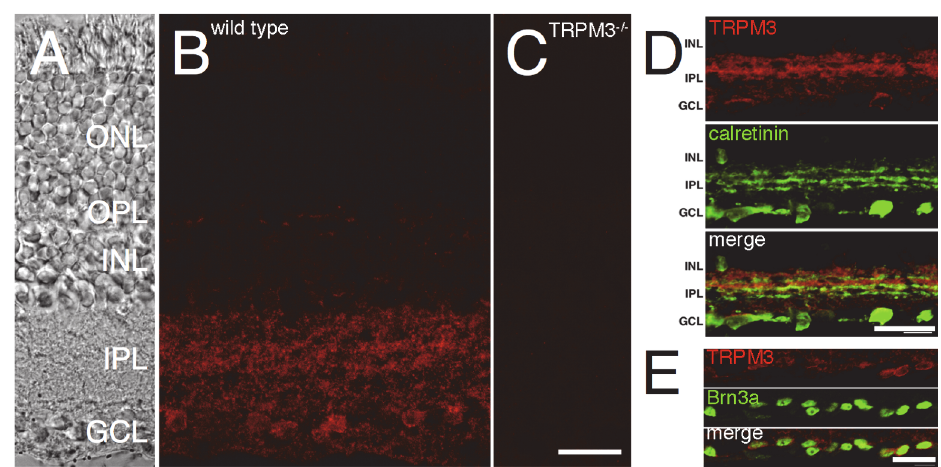
B ) TRPM3 immunoreactivity is observed in the IPL and GCL of a WT mouse retina. C ) No immunoreactivity is detected in a retinal section from a TRPM3 -/- mouse. D ) Transverse retinal sections of the inner retina double- labeled for TRPM3 (top, red) and calretinin (middle, green). Visible in the merged image (bottom), the outer, OFF half of the IPL (sublamina a) is more strongly labeled than the inner, ON, sublamina b. E ) Imaging of the ganglion cell layer, double-labeled for TRPM3 (top, red) and Brn3a (middle, green). The merged image (bottom) shows that Brn3a-positive ganglion cells express TRPM3. Abbreviations are as follows: ONL, outer nuclear layer; OPL, outer plexiform layer; INL, inner nuclear layer; IPL, inner plexiform layer; GCL, ganglion cell layer. Scale bars = 20 μ